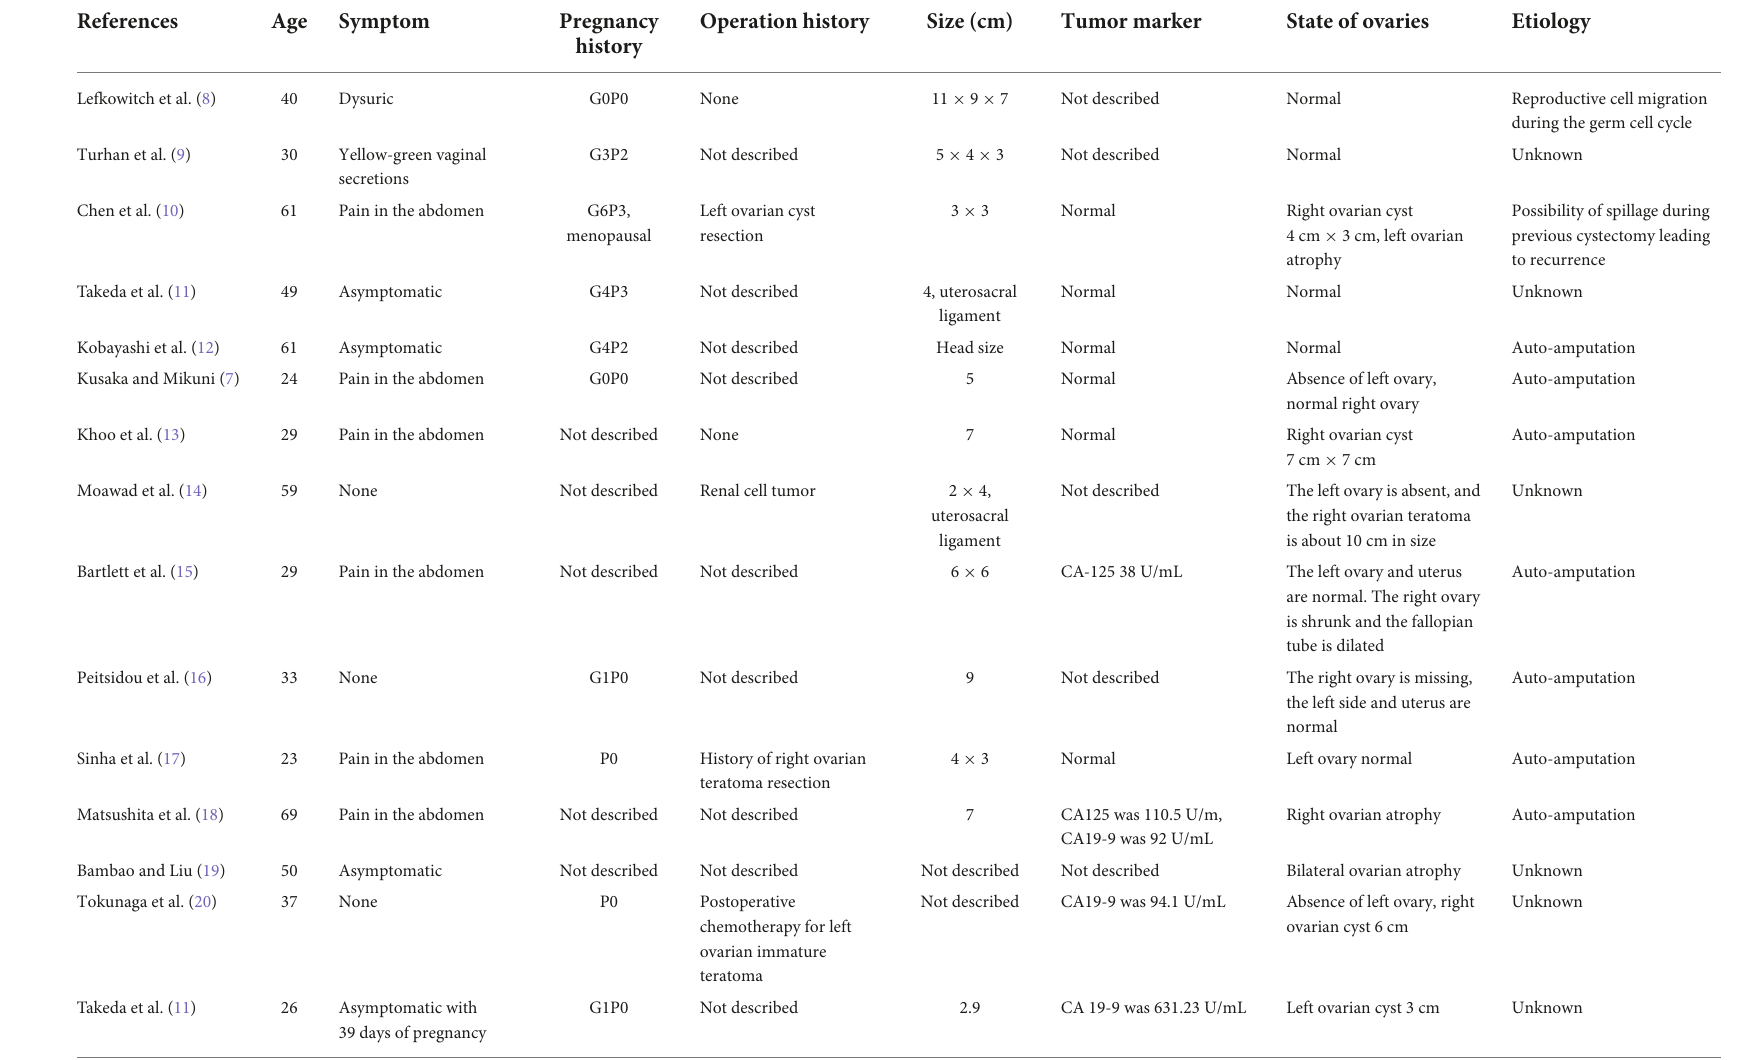
TABLE 1 Case summary of extragonadal teratoma in Douglas’